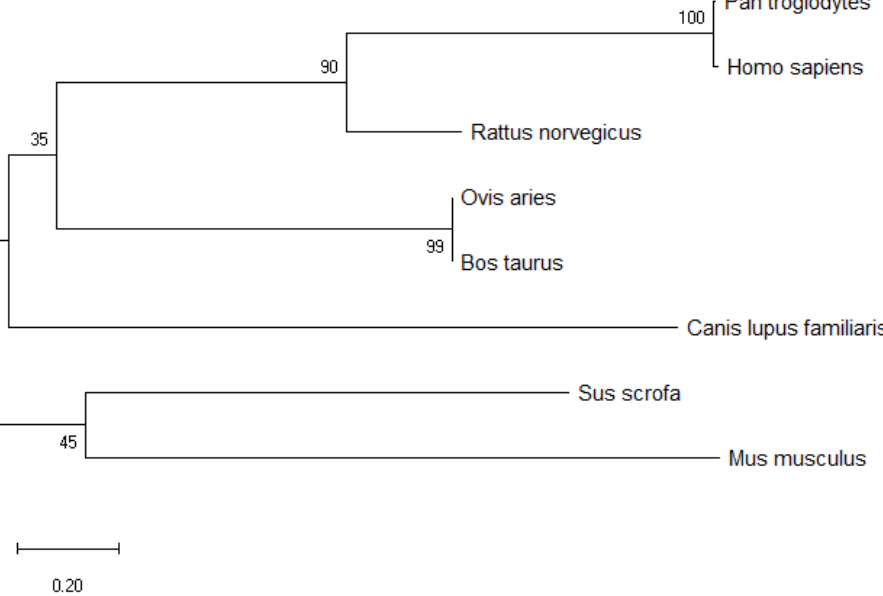
Figure 3. Activity analysis of the − 758 bp to − 545 bp region of the Hu sheep BMP7 promoter. Note that for B5, the target fragment ( − 758 bp to − 545 bp) was ligated to the pGL3-Base vector; B3 was the normal control group. The marker “**” represents a highly significant di ff erence ( p < 0.01).